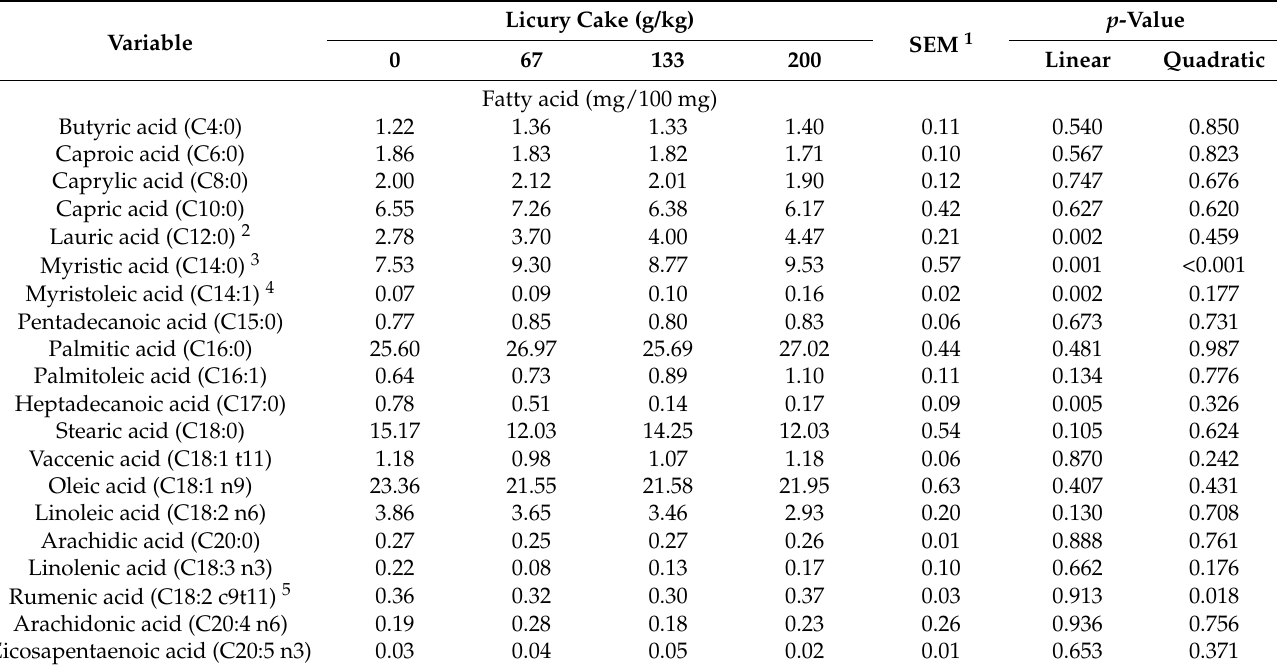
Table 3. Fatty acids of milk from lactating goats fed diets with increasing levels of licury cake.